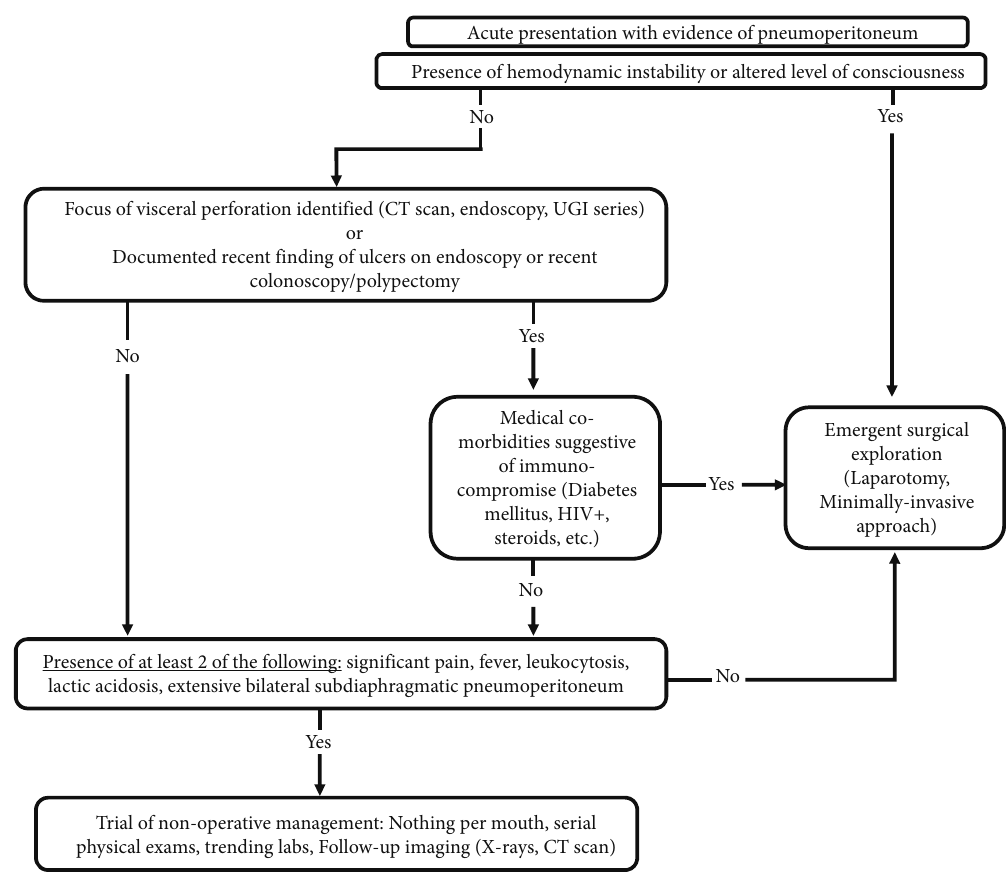
Figure 4: Suggested algorithm for approach to workup and management of spontaneous